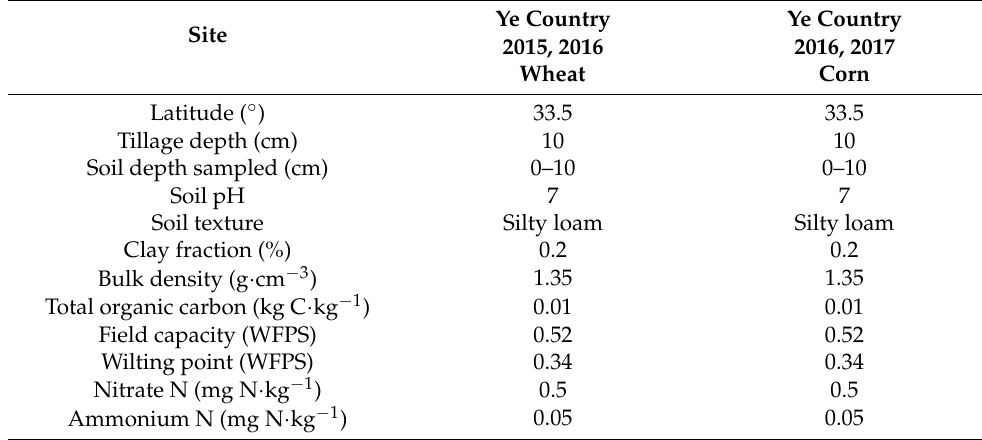
Table 2. The DNDC Model Input Parameters for Ye